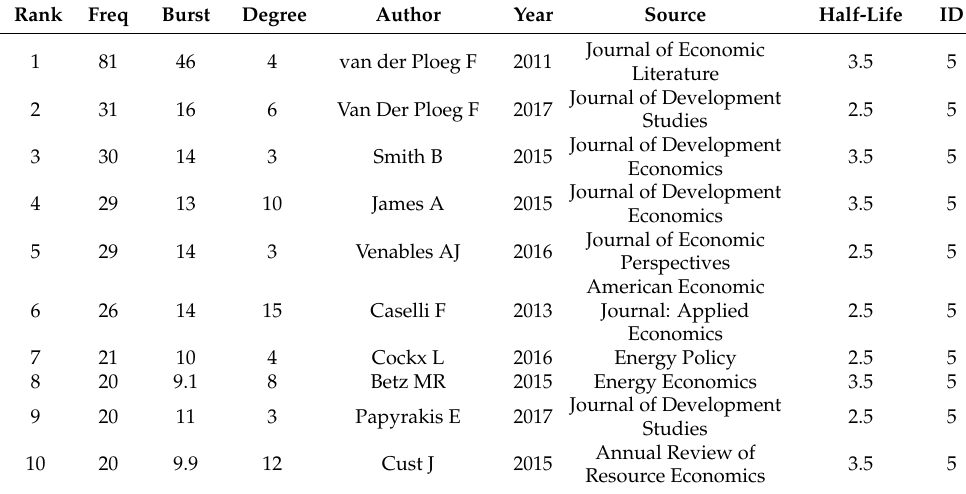
Table A5. Cluster 5 high-impact members.